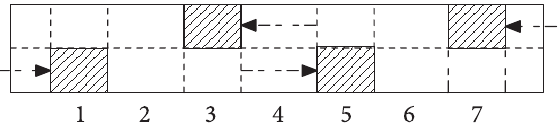
Fig. 8. An example of passing the construction works corridor in a bi-directional “green wave”